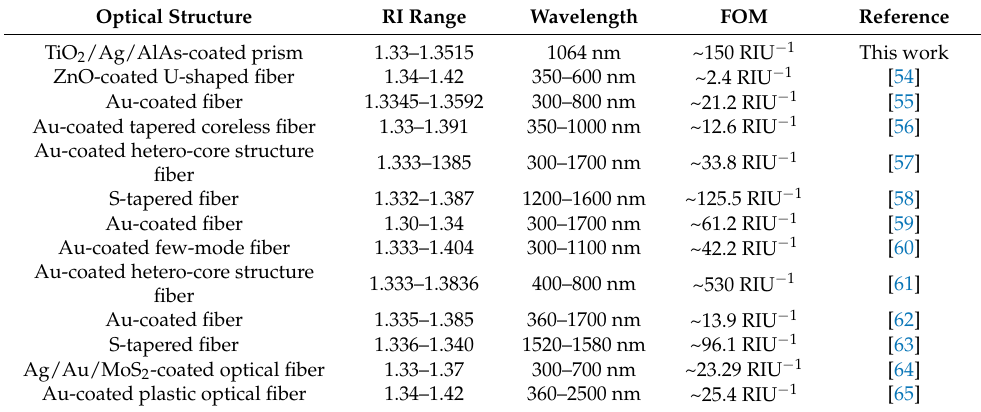
Table 5. Performance of SPR-based